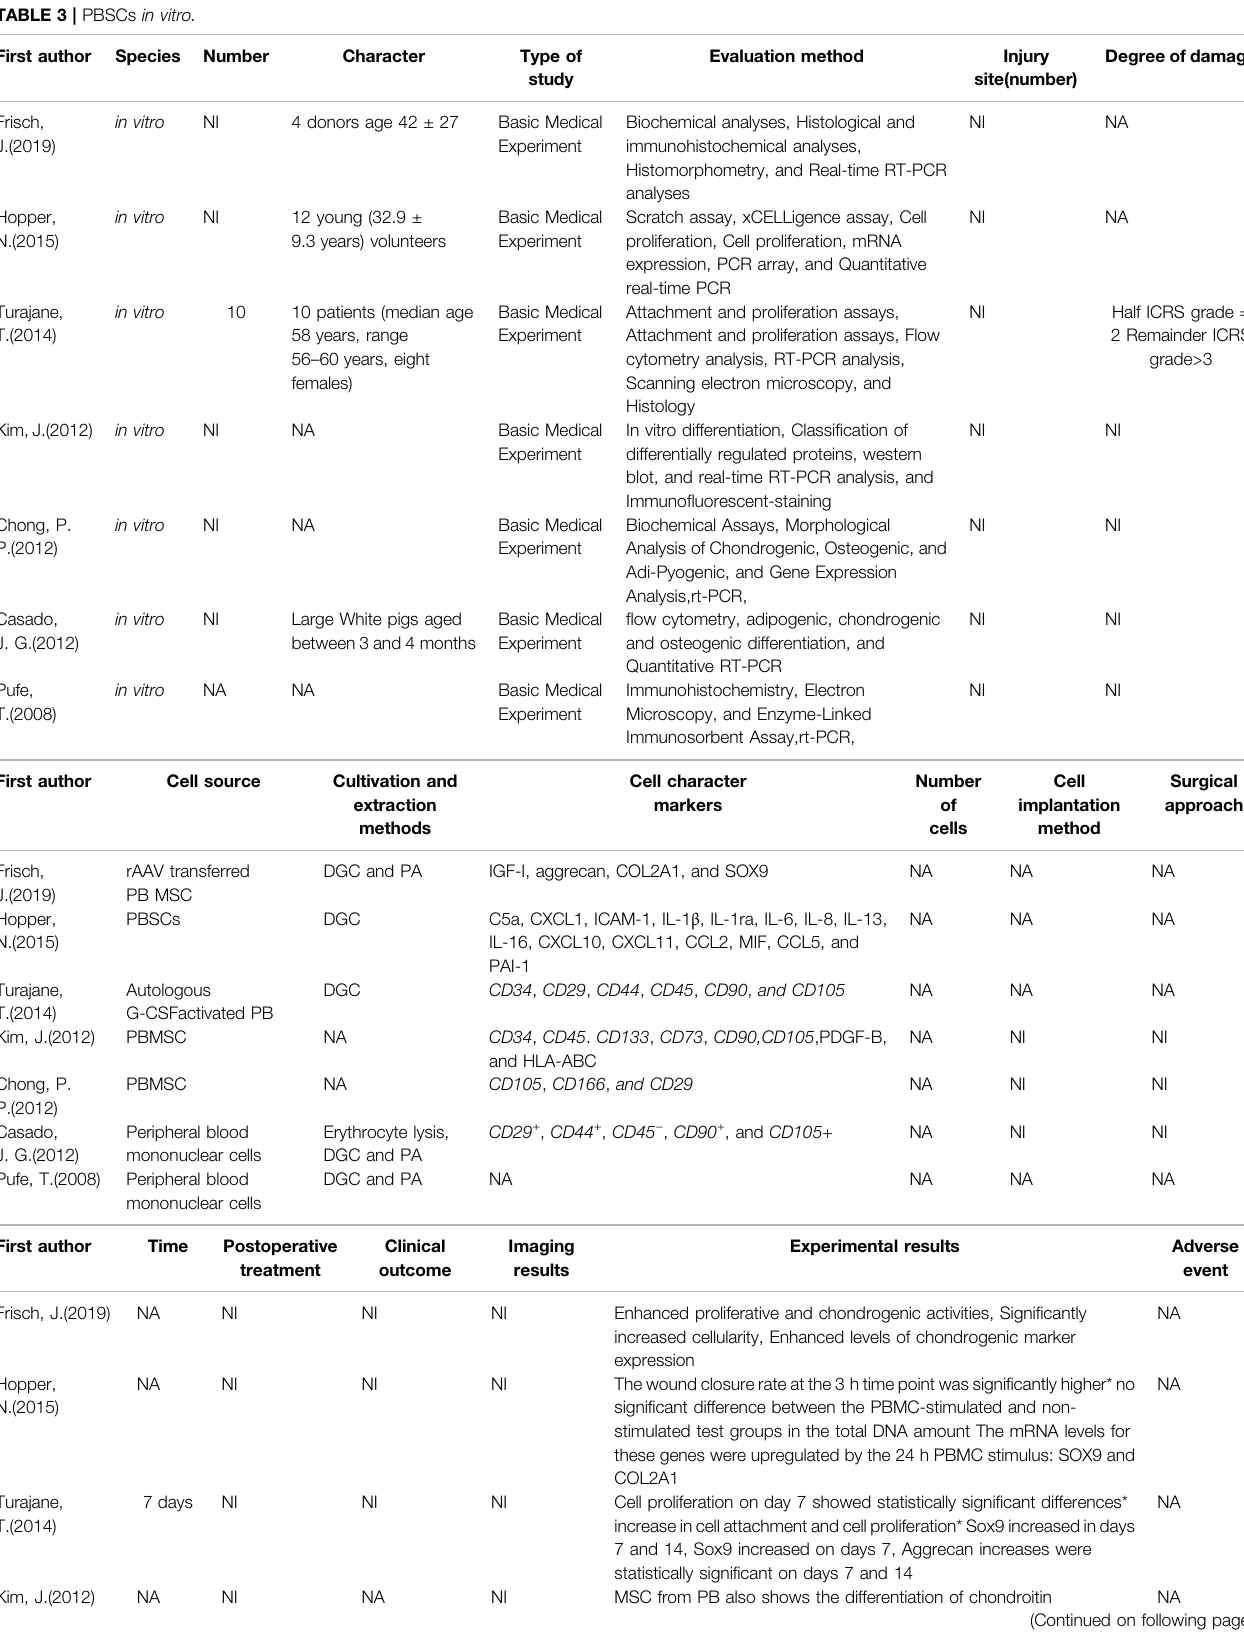
TABLE 3 | PBSCs in